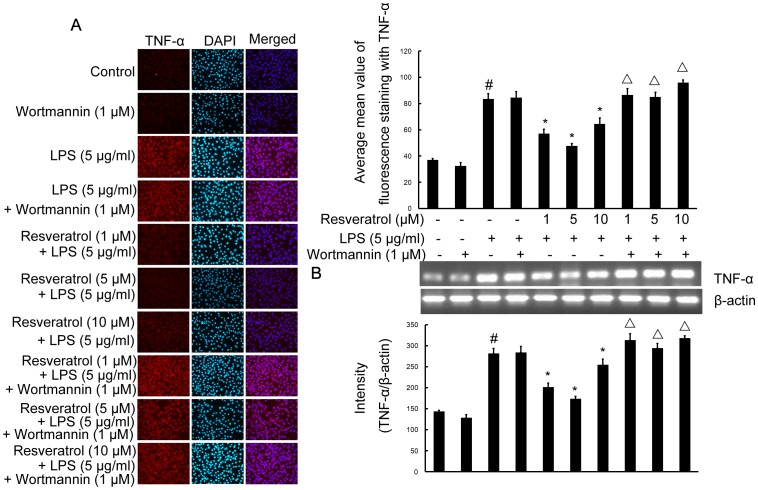
PI3-K is involved in resveratrol-attenuated the production of the proinflammatory cytokine TNF-α at the transcriptional and translational levels in RAW 264.7 macrophage cells.Panel A shows the immunofluorenscence images for protein expression of TNF-α and Panel B shows the corresponding mRNA data. The relative mRNA level was quantified by scanning densitometry and normalized to β-actin mRNA. Note the up-regulated protein and mRNA expression of TNF-α by LPS is suppressed by different concentrations of resveratrol; however, in cells pretreated with PI3-K inhibitor wortmannin, the suppressive effect of resveratrol is abrogated. The values shown are mean ± SEM of data from three independent experiments. #Significant compared with control alone, p<0.05. *Significant compared with LPS alone, p<0.05. ΔSignificant compared with resveratrol + LPS, p<0.05.